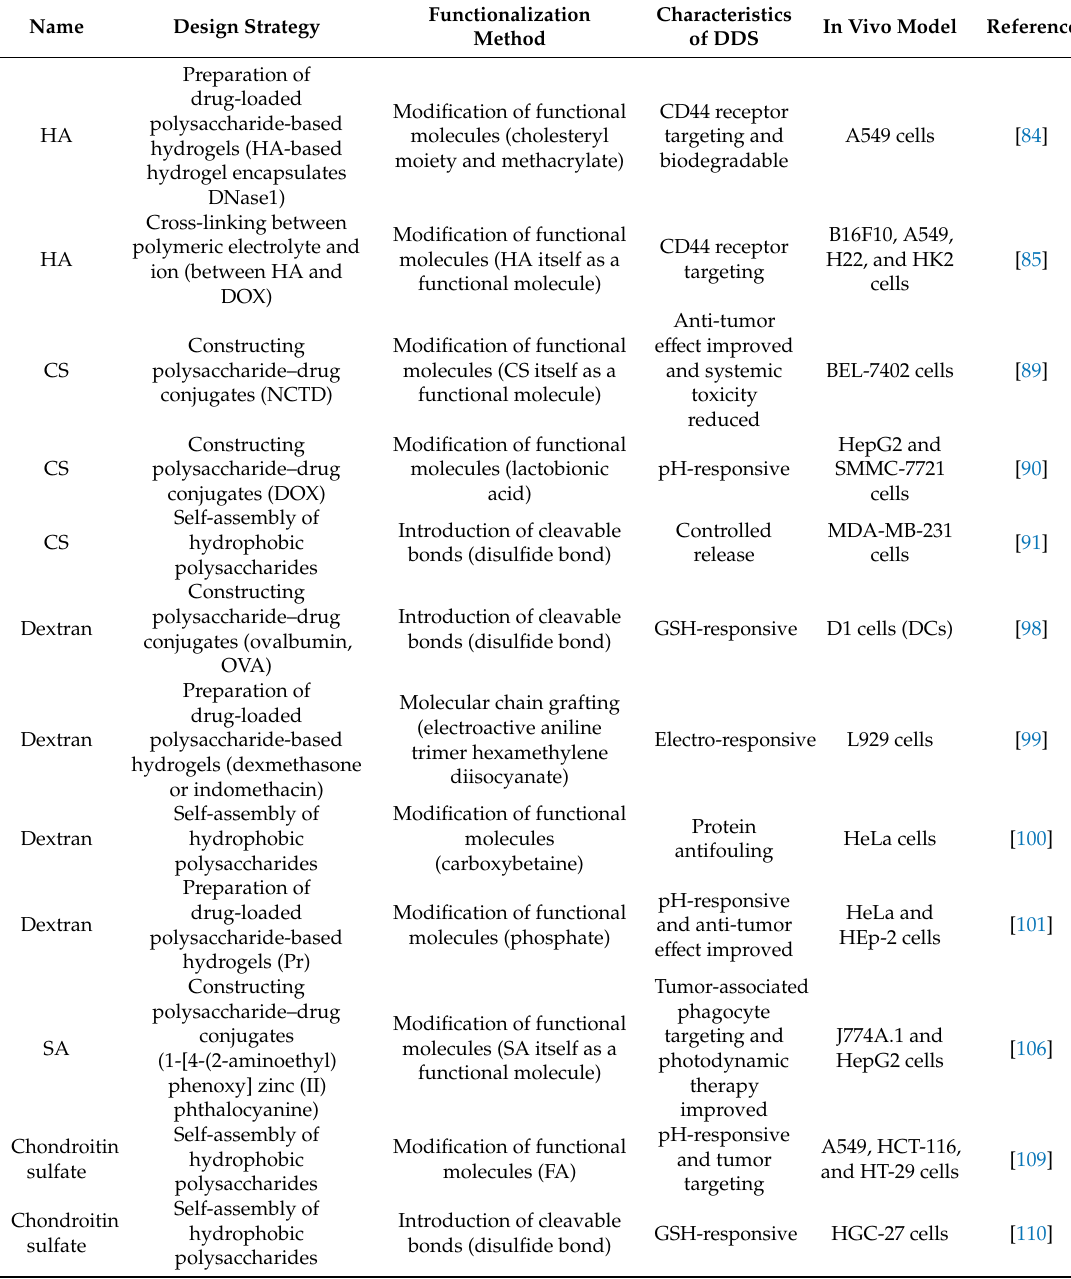
Table 2. Research progress of common polysaccharide-based